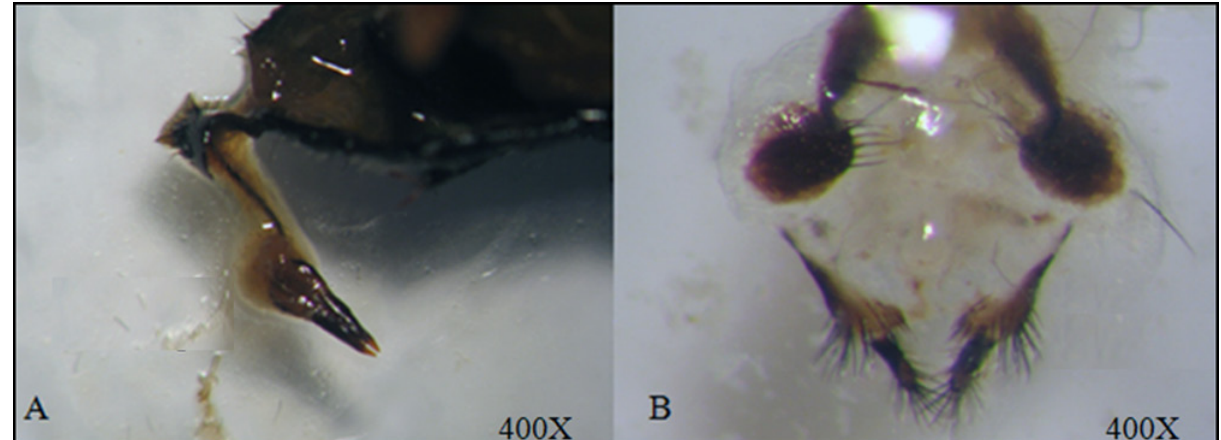
Figure 1. External genitalia of Hycleus scabiosae ( A ) aedeagus in male , and ( B ) paired valvifers in